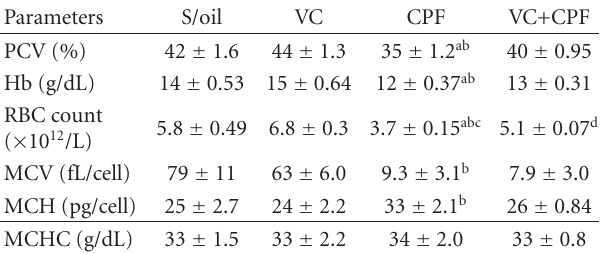
Table 1: E ff ect of chronic exposure to soya oil (S/oil), vitamin C (VC), and/or chlorpyrifos (CPF) on pack cell volume (PCV), red blood cell (RBC) and hemoglobin (Hb) concentrations, and erythrocyte indices in Wistar rats.